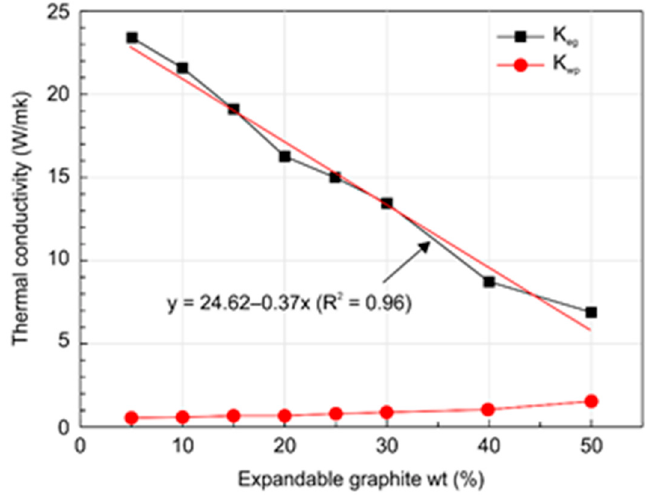
Figure 14. Thermal conductivity variations with expandable graphite